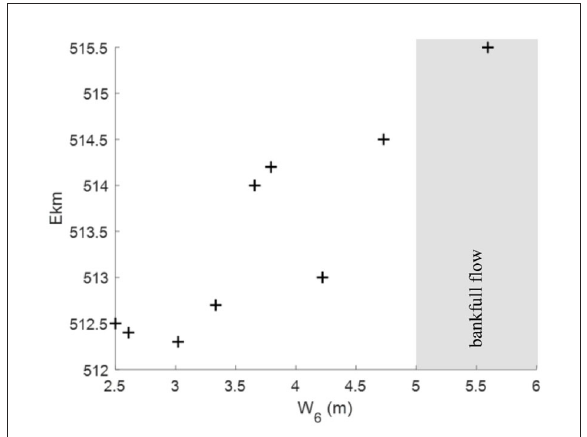
FIGURE7 Origin of bar formation depending on the mean water level measured at gauging station Neu Darchau over a period of 6 weeks before the underlying echo sounder survey. The region of water levels that approximately represent bank full conditions in the investigated sections (c.f. Section 2.1) is highlighted in